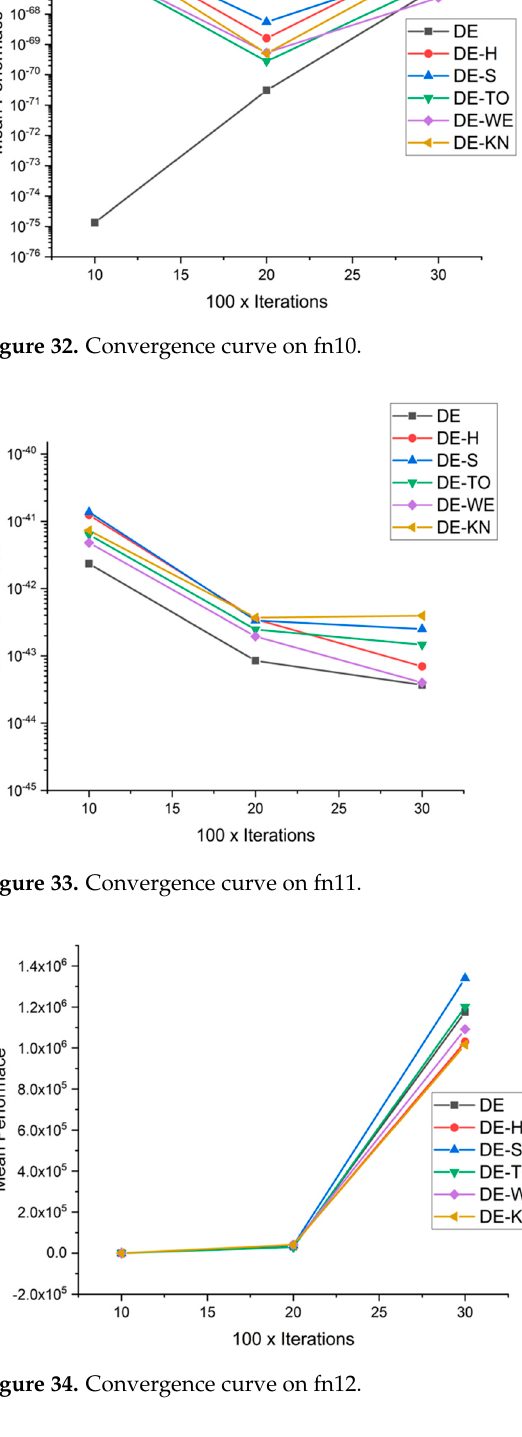
Figure 34. Convergence curve on fn12.